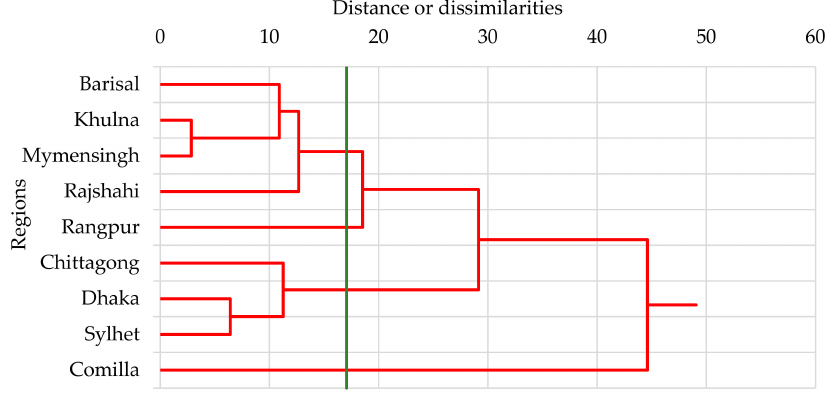
Figure 2. Dendrogram showing clusters for main income sources, by